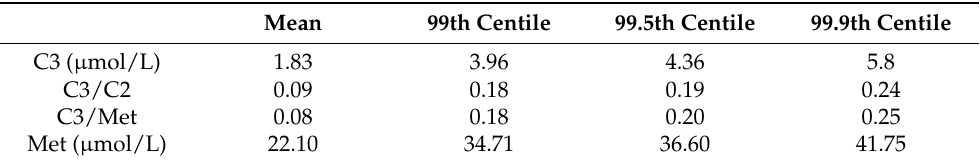
Table 1. Index distributions of dried blood spots from newborns in the Hiroshima area from April 2016 to March 2017 ( n = 23,467).